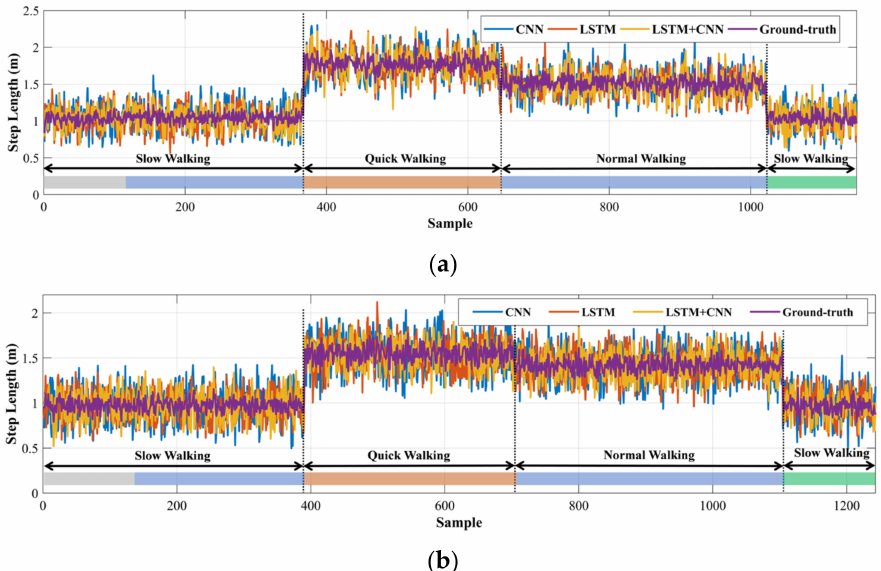
Figure 11. Qualitative comparison of the stride-length estimation results with a single network, CNN and LSTM, and a combined network, LSTM + CNN, on the sequence #7 ( a ) and #11 ( b ) in different scenes (indoor stadium, sidewalk, playground, and supermarket, are represented by color strip corresponding to gray, blue, orange, and green, respectively).